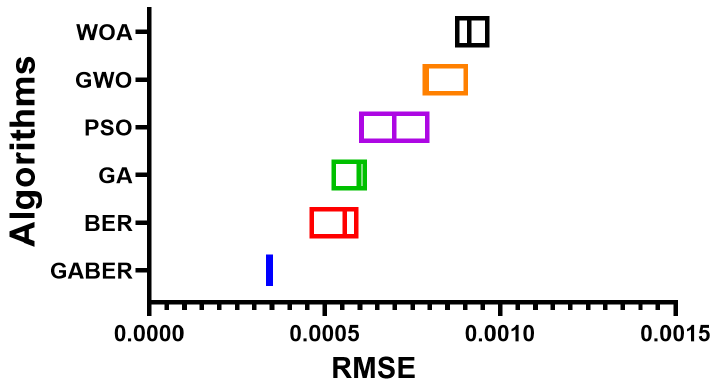
Figure 11. RMSE of the results achieved by the proposed optimized stacked ensemble method compared to other methods applied to the wind speed dataset.